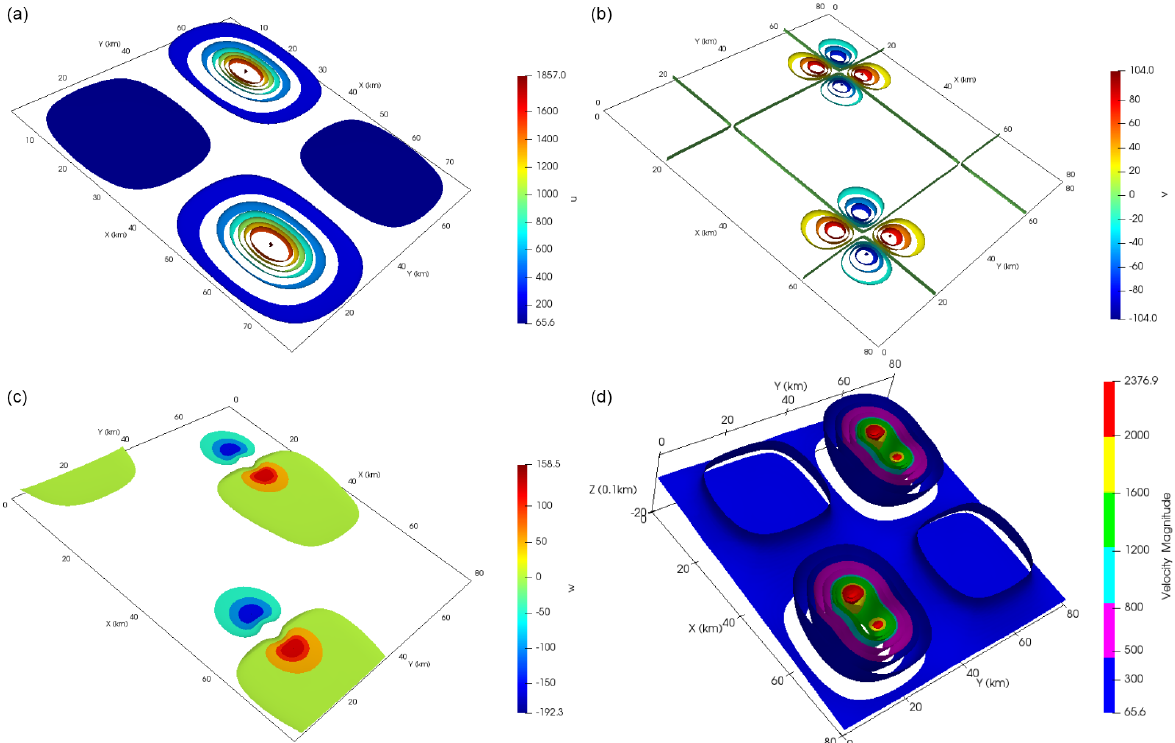
Figure 8. A simulation of the ice sheet model with θ = 0 . 7387 and β = 901 . 5232, discretized at the highest grid resolution. The top two plots display contours of the velocity components u 1 and u 2 , respectively, on the top surface (cid:48) s . The third plot displays a contour plot of velocity component u 3 . The fourth plot displays a cutaway plot of the velocity magnitude | u | inside the sheet.